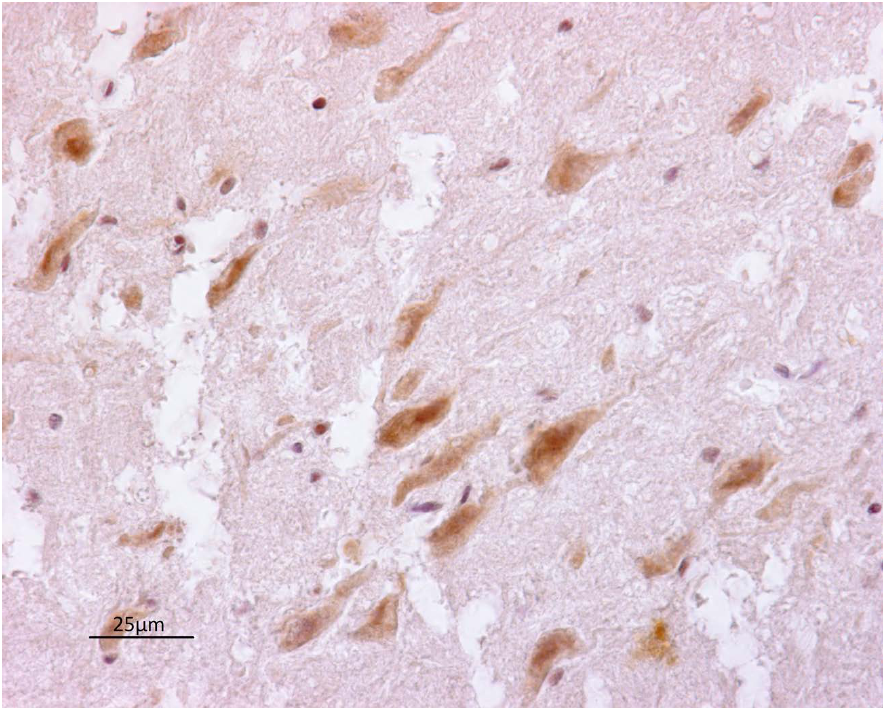
Figure 3. Brainstem. Pseudorabies virus positivity in neurons (arrow) (40 ×